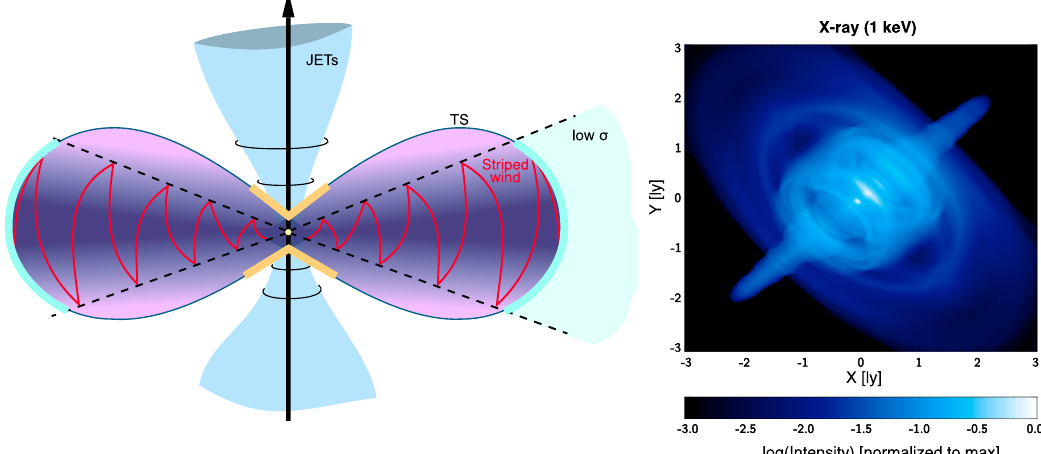
Figure 3. Left panel: Cartoon of the inner nebula geometry (the oblate TS, jets formation, striped wind) with the identification of the accelerating regions for particles responsible for the wisps emission at different wavelengths. Right panel: Surface brightness map at X-ray energies (1 keV), with intensity normalized to the maximum value and expressed in logarithmic scale. Reprinted with permission from Del Zanna et al. (2006) © 2006